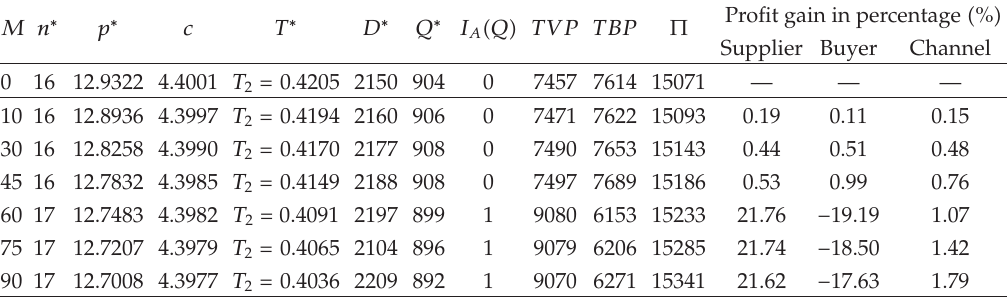
Table 2: Influence of optimal solution with di ff erent M